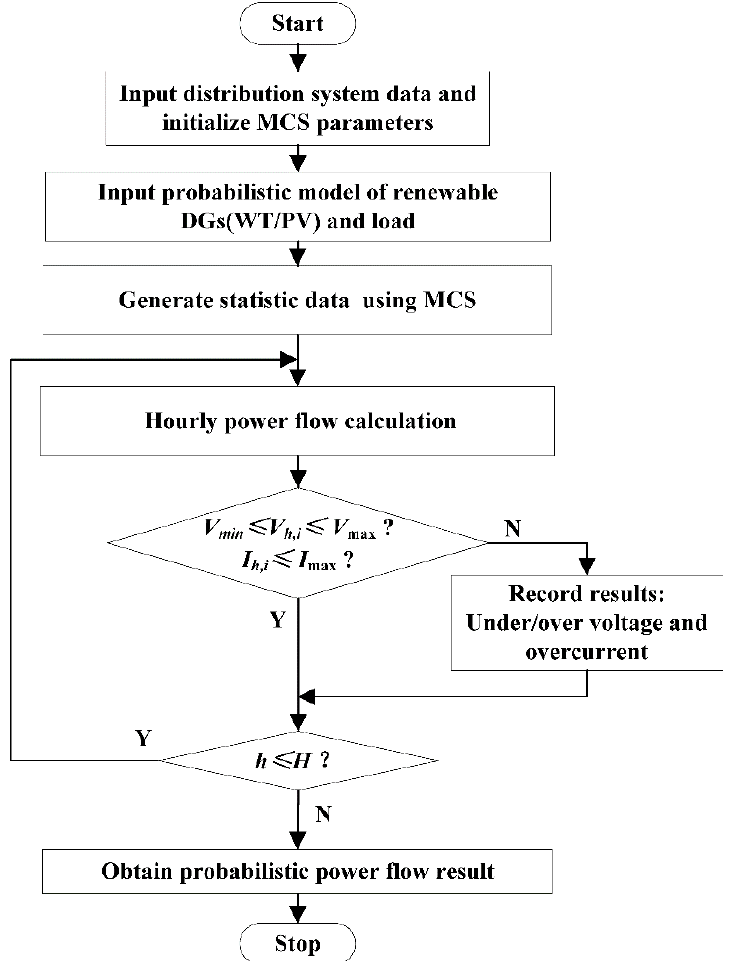
Figure 1. Flowchart of MCS ‐ based PPF calculation.